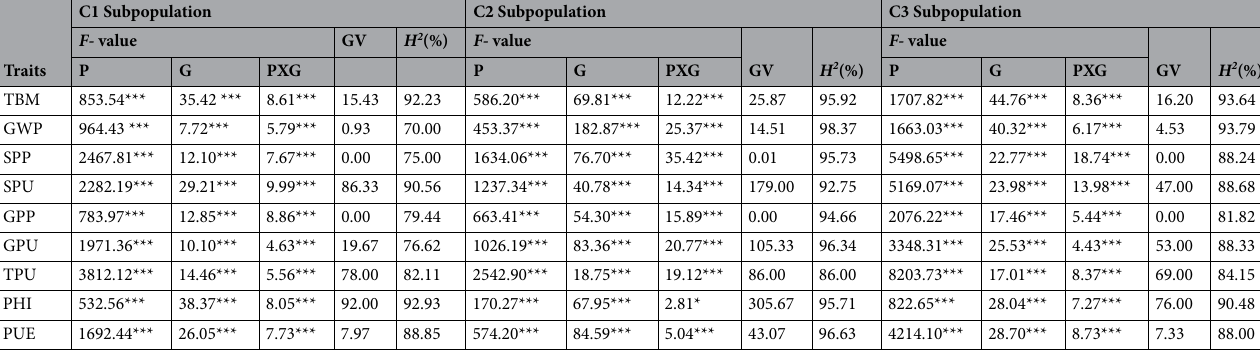
C2 Subpopulation C3 Subpopulation